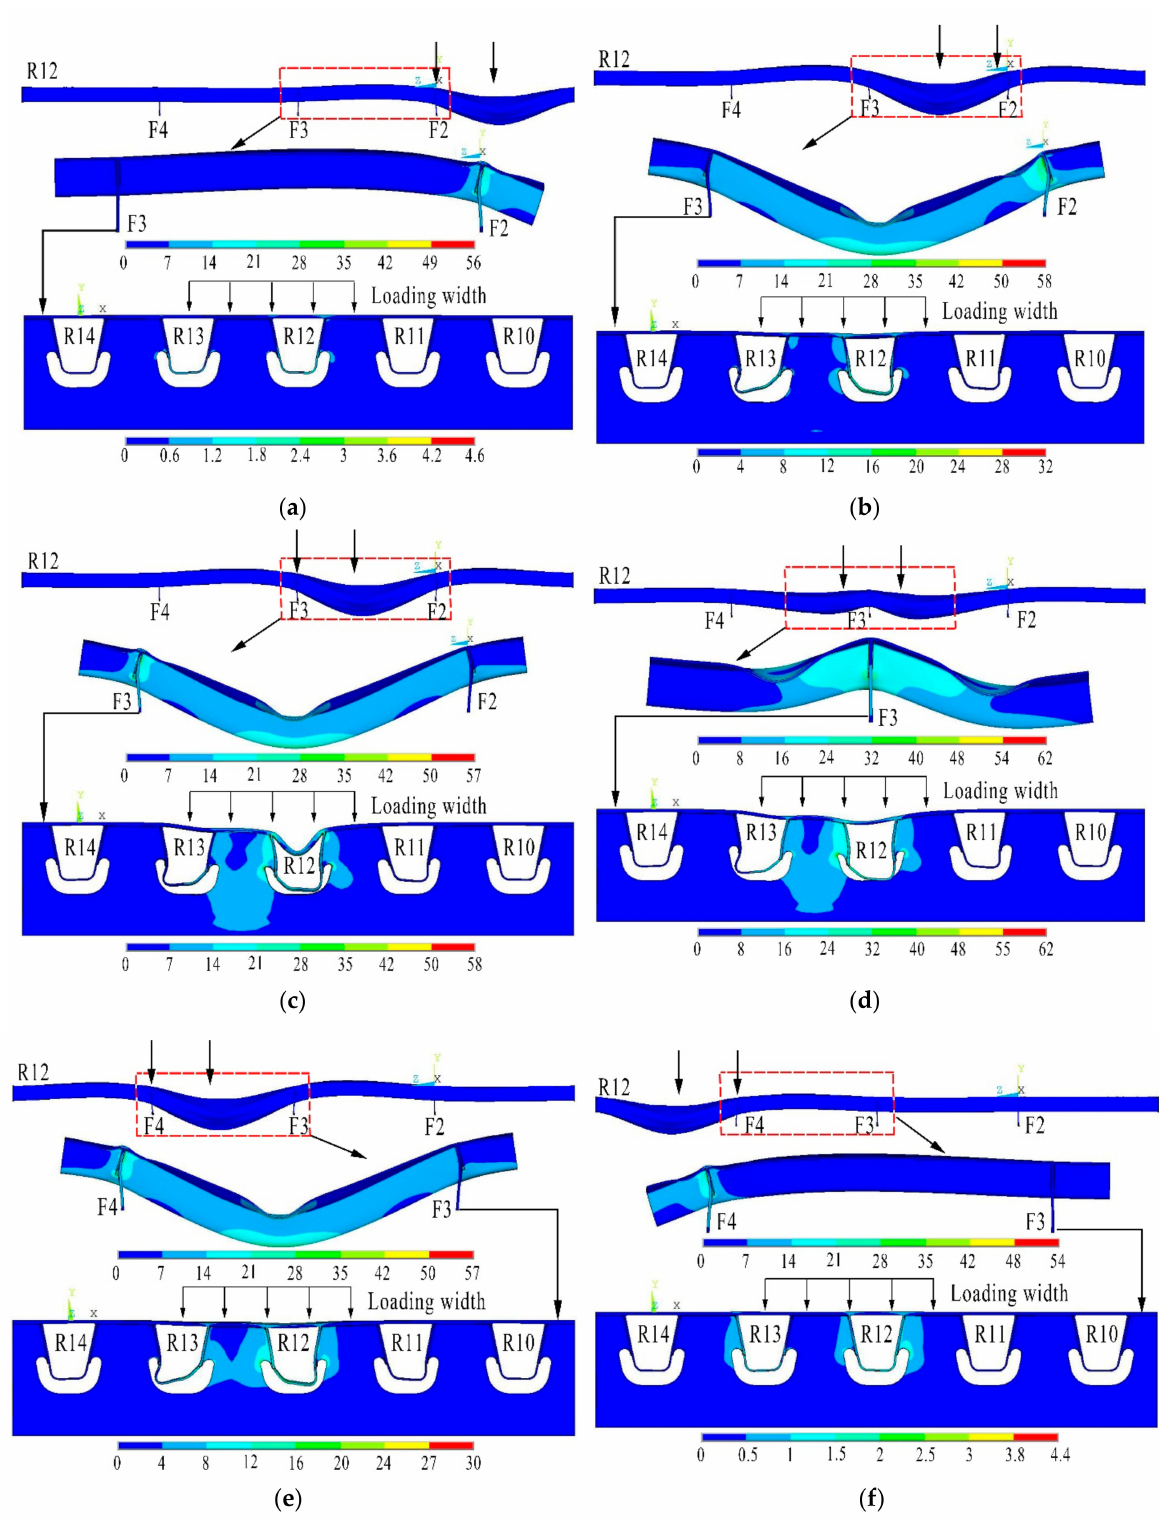
Figure 20. Stress contours and deformation plots under LC2. ( a ) Z = 0 m; ( b ) Z = 1.5 m; ( c ) Z = 3.0 m; ( d ) Z = 3.6 m; ( e ) Z = 6 m; ( f ) Z = 7.4 m. (Unit: